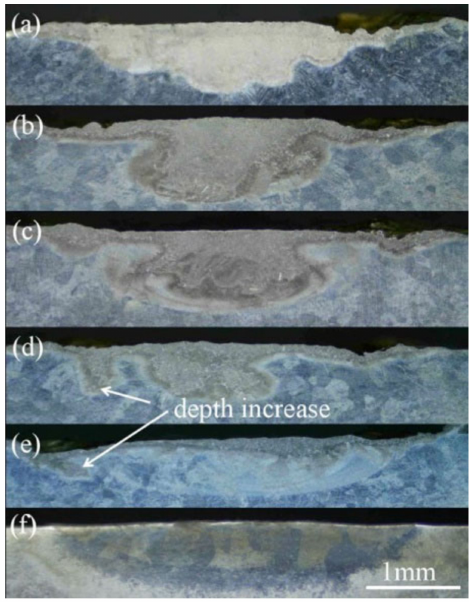
Figure 12. OM image of the cross section of the nitrided layers obtained for di ff erent nitrogen (in argon) concentrations: ( a ) 100% nitrogen, ( b ) 82% nitrogen 18% argon, ( c ) 64% nitrogen 36% argon, ( d ) 46% nitrogen 54% argon, ( e ) 18% nitrogen 82% argon, and ( f ) 5% nitrogen 95%